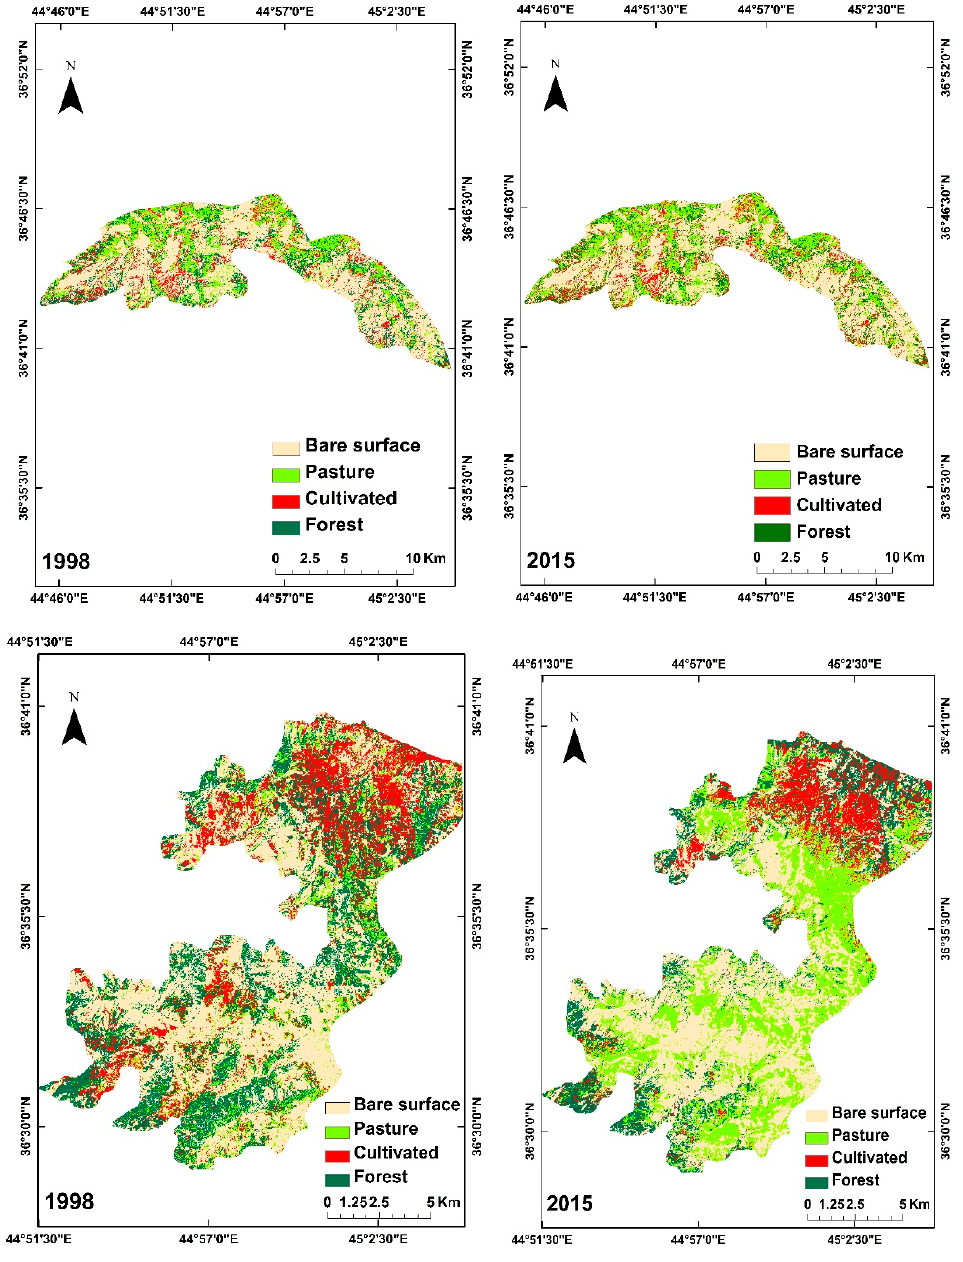
Figure 2. The classified land use and land cover (LULC) maps for upper and lower parts of HSCZ for years 1998 and 2015 from Random Forest classifier with Landsat data, which compare the changes in two parts over time.